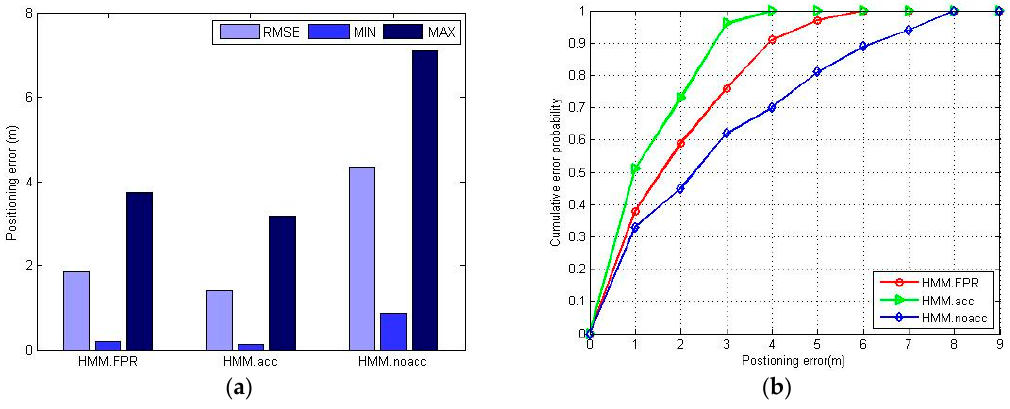
Figure 15. The positioning errors of HMM.FPR, HMM.acc, HMM.noacc: ( a ) maximum positioning error, minimum positioning error and RMSE of different positioning methods; ( b ) CDF of different positioning methods.